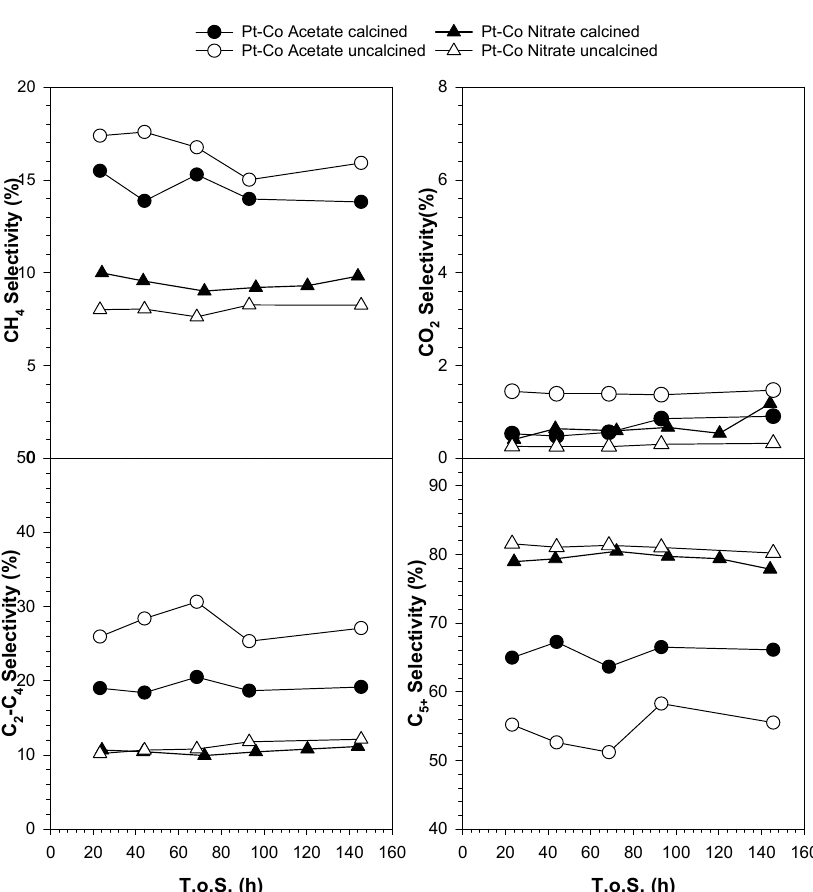
Figure 18. Selectivity results of catalyst testing in the CSTR (T = 220 °C, P = 20 atm, H 2 /CO = 2 mol/mol, SV = 6 slph/g cat ). Table 5. CO conversion and product selectivity for the catalysts tested at similar CO conversions (process conditions: T = 220 °C, P = 300 psi, H 2 /CO = 2 mol/mol, SV varied).